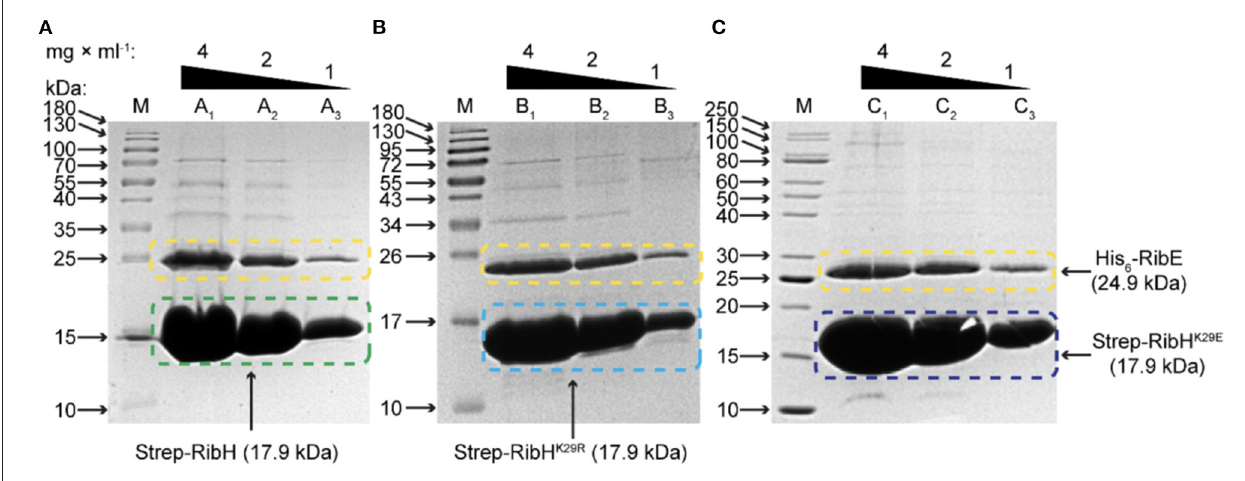
FIGURE 8 | SDS-PAGE analysis for encapsulation of His 6 -RibE by Strep-RibH and its mutants Strep-RibH K29R and Strep-RibH K29E . Proteins have been coproduced in E. coli BL21 Star and purified by Strep-Tactin affinity chromatography followed by SEC. The respective fractions from 60-mer peaks in SEC with apparent MM of ∼ 1 MDa have been pooled, concentrated, and analyzed by SDS-PAGE in order to study encapsulation of His 6 -RibE. (A) Encapsulation of His 6 -RibE (24.9 kDa) by wt-like Strep-RibH (17.9 kDa). In lane M, the protein ladder has been applied, lanes A 1 , A 2 , and A 3 denote for 4, 2, and 1 mg/ml of purified protein, respectively. (B) Encapsulation of His 6 -RibE (24.9 kDa) by mutant Strep-RibH K29R (17.9 kDa). In lanes denoted with M, the protein ladder has been applied; lanes B 1 , B 2 , and B 3 denote for 4, 2, and 1 mg/ml of purified protein, respectively. (C) Encapsulation of His 6 -RibE (24.9 kDa) by mutant Strep-RibH K29E (17.9 kDa). In Lane M, the protein ladder has been applied; Lanes C 1 , C 2 , and C 3 denote for 4, 2, and 1 mg/ml of purified protein,